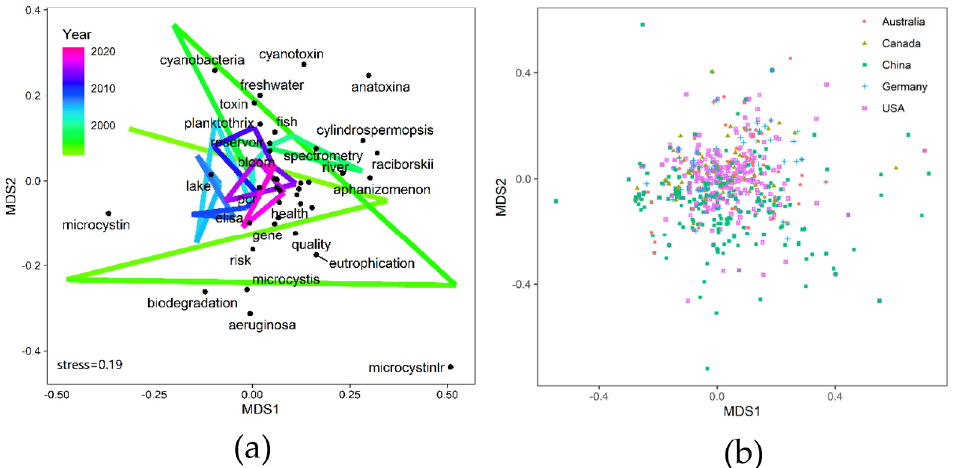
Figure 4. NMDS analysis of abstract words. ( a ) The lines of different colors in the panel on the left indicate the connections between the mean values of the NMDS scores of publications in different years. ( b ) The points represent the point scores for publications from different countries.